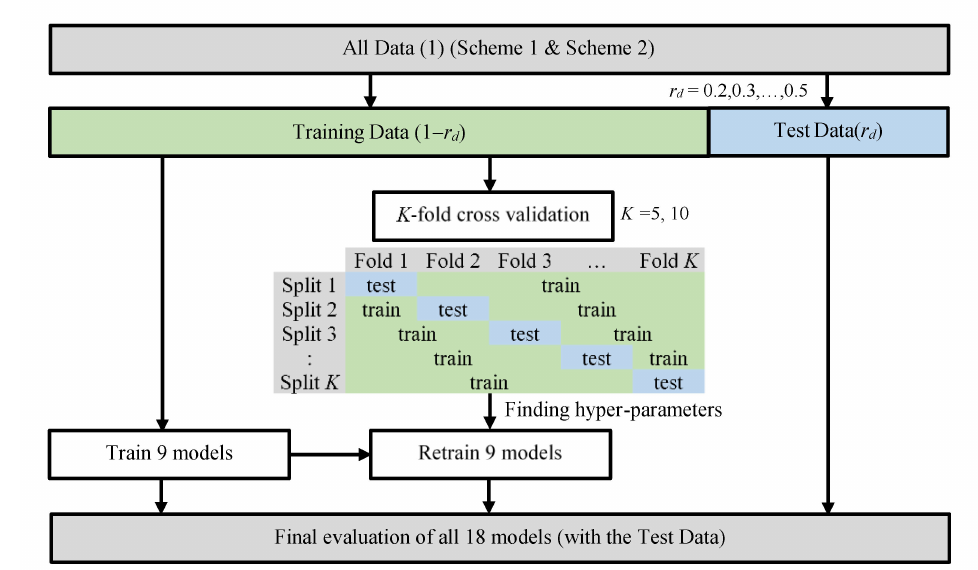
Figure 2. Data processing for model training and